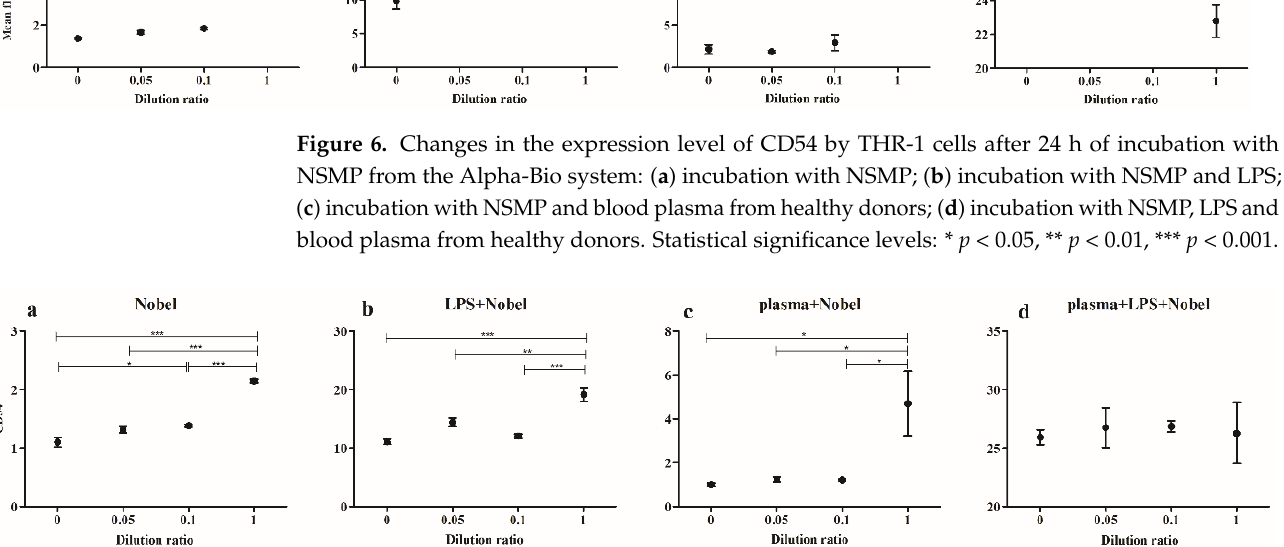
Figure 7. Changes in the expression level of CD54 molecules by THP-1 cells after 24 h of incubation with NSMP from the Nobel Replace system: ( a ) incubation with NSMP; ( b ) incubation with NSMP and LPS; ( c ) incubation with NSMP and blood plasma from healthy donors; ( d ) incubation with NSMP, LPS and blood plasma from healthy donors. Statistical significance levels: * p < 0.05, ** p < 0.01, *** p < 0.001.